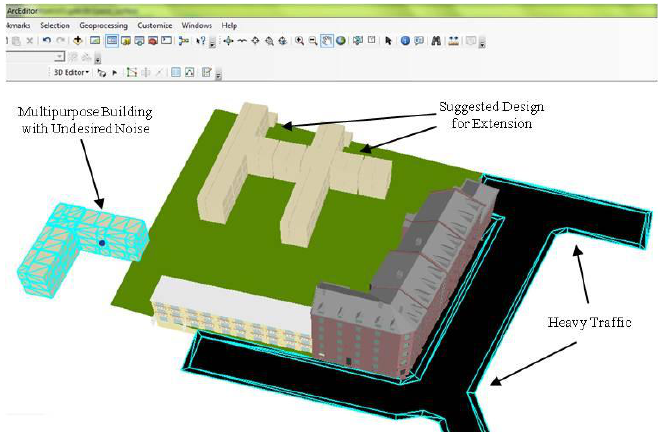
Figure 15. Suggested extension for the patient ward.